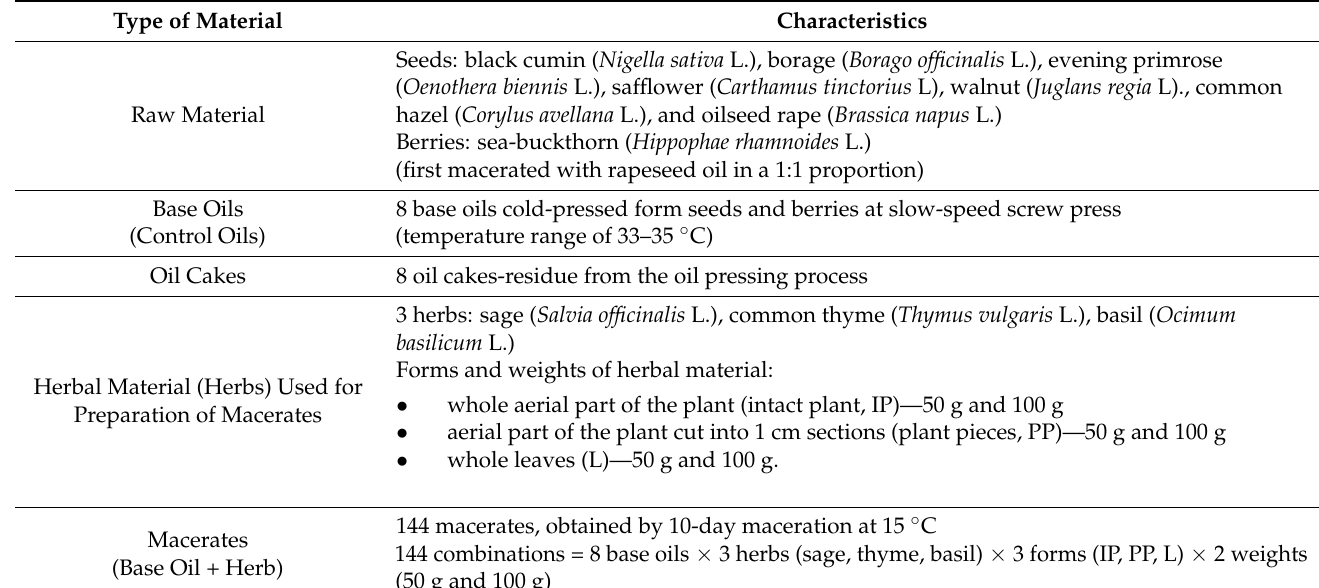
Table 1. Type and characteristics of the plant materials used in the experiment. Type of Material Characteristics